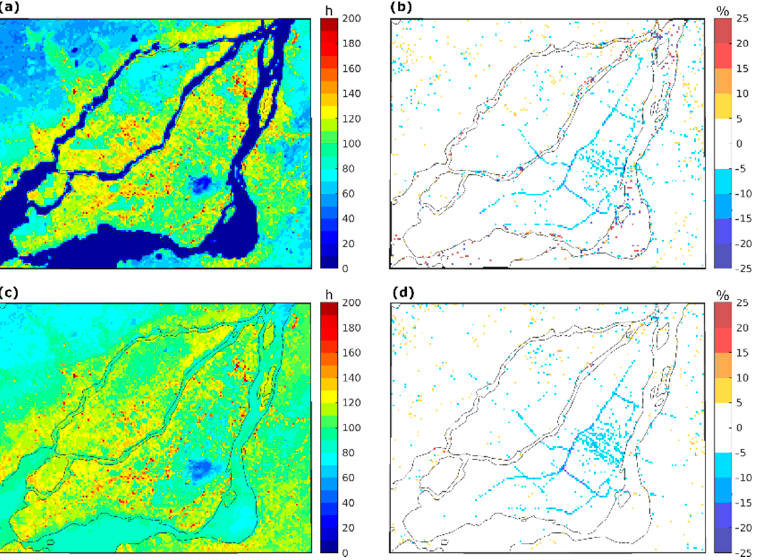
Figure 8. ( a ) Hours with 2 m temperature exceeding 30 °C in the GEM100 simulation. ( b ) Relative difference in hours with 2-m temperature exceeding 30 °C between the GEM20 and the GEM100 simulations. ( c ) Hours with humidex exceeding 35 in the GEM100 simulation. ( d ) Relative difference in hours with humidex exceeding 35 between the GEM20 and the GEM100 simulations.